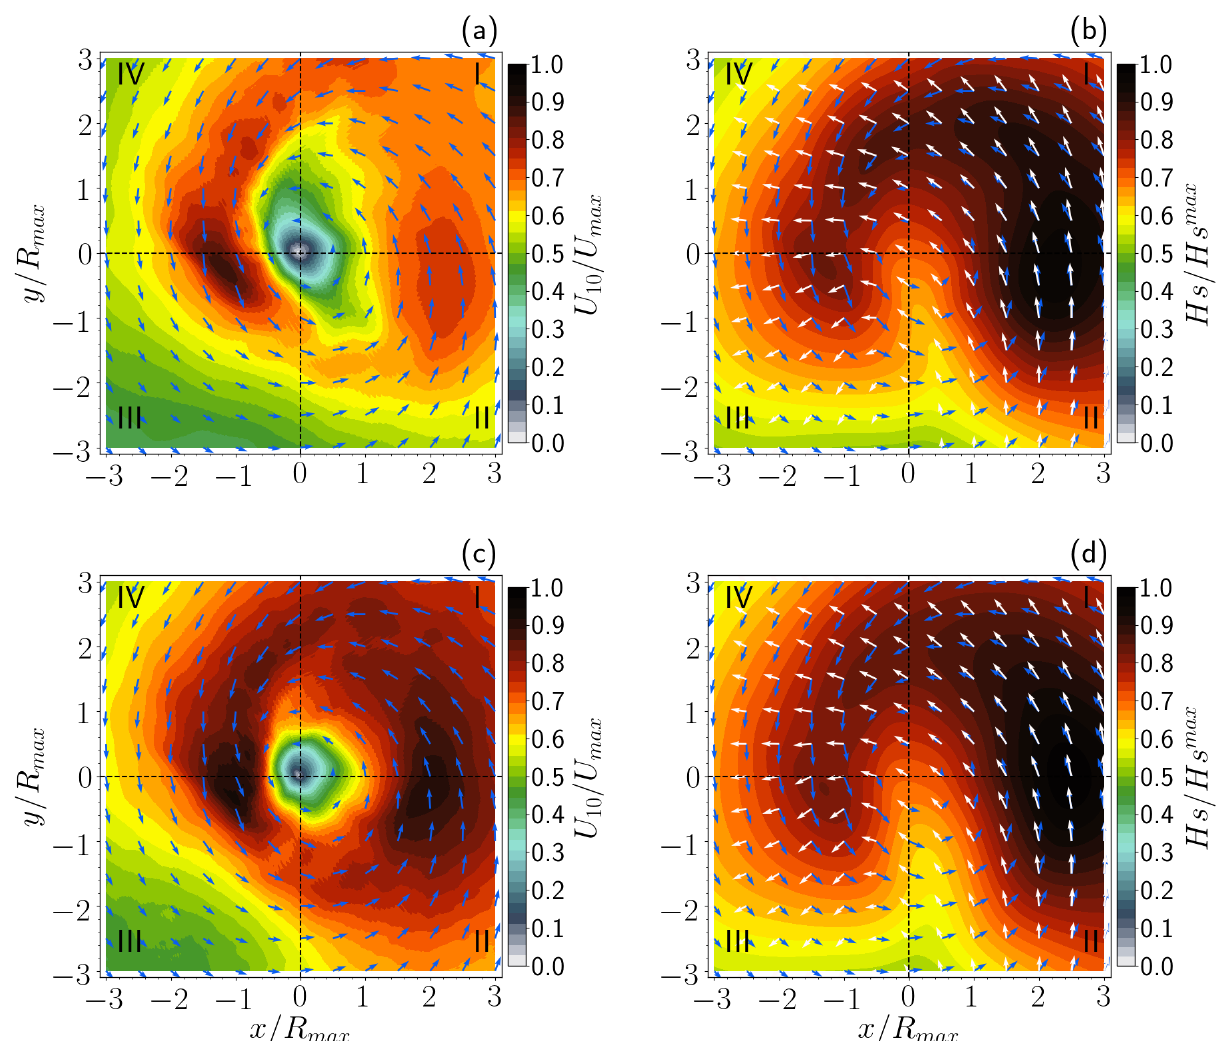
Figure 7. Average U 10 and Hs fields for the 3 h period in which the storm reaches the category 1 hurricane stage. At the top panel, the wind ( a ) and significant wave height ( b ) average fields computed with the original data. At the lower panel, the wind ( c ) and significant wave height ( d ) average fields are computed with filtered